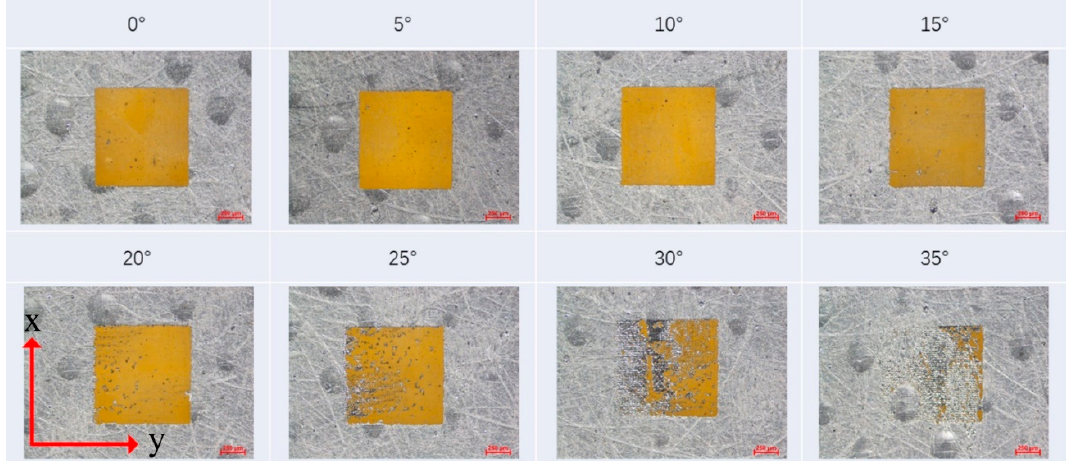
Figure 3. Etching evolution pictures captured with an optical microscope for the increased laser incident angle from 0 to 35°. The etched area was a series of 1 × 1 mm squares.